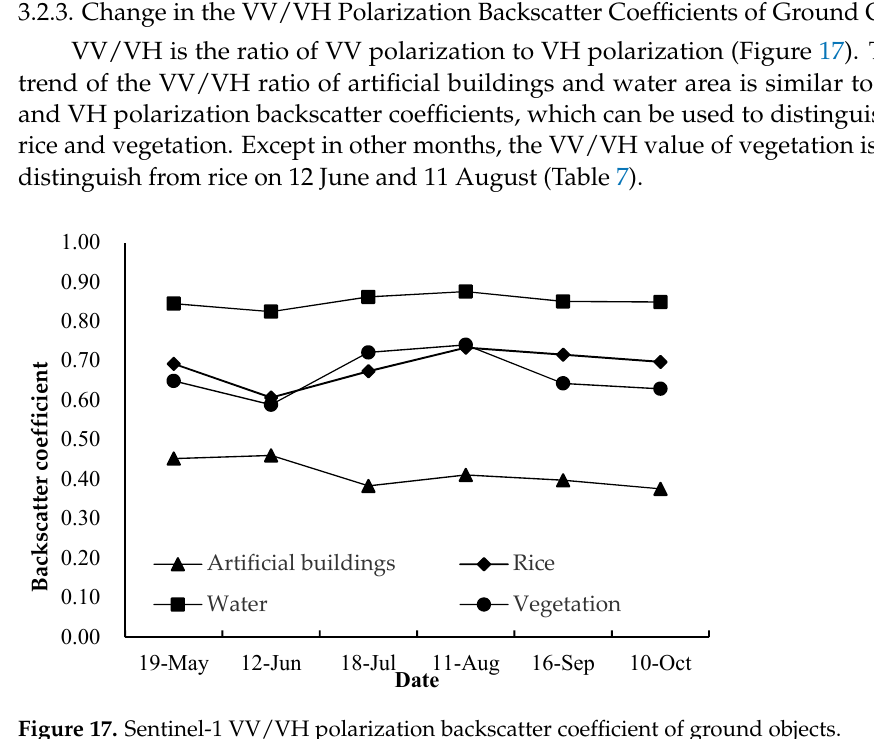
Table 7. VV/VH polarization backscatter coefficient of ground objects.